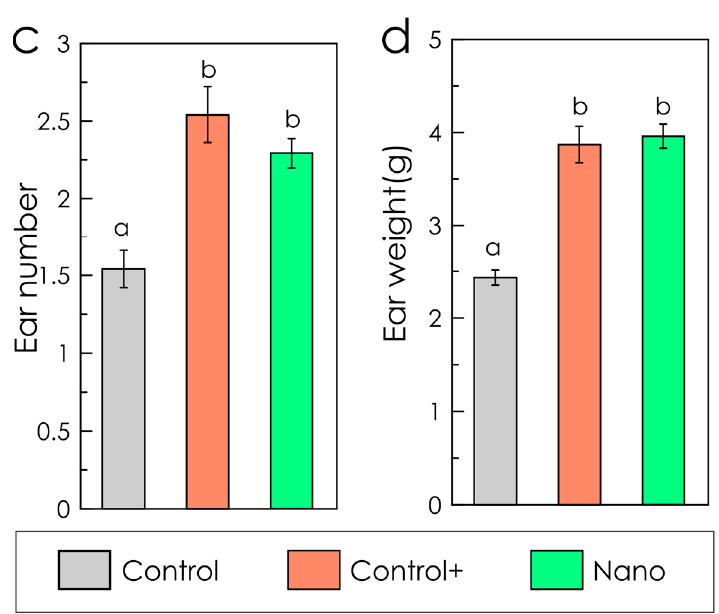
Figure 3. Plant growth and development parameters of durum wheat. Shoots number ( a ), average weight ( b ), ear number ( c ), and ear weight ( d ) per individual wheat plant. Data are expressed as mean ± standard error. Data with different letters are statistically different ( p ≤ 0.05). Total Nitrogen dosages were 36 kg N ha − 1 as granular DAP (control); 186 kg N ha − 1 as granular DAP (positive control); and 111 kg N ha − 1 , of which 15 kg N ha − 1 as sprayed aqueous suspension of U-ACP and 96 kg N ha − 1 as granular DAP (nano-treatment).